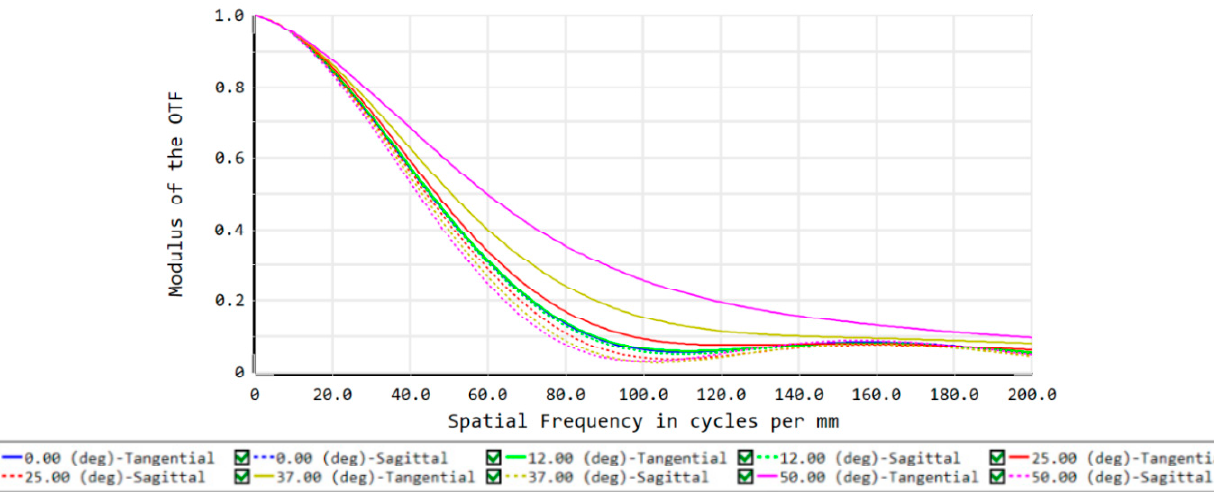
Figure 6. MTF curves of the front concentric imaging group.